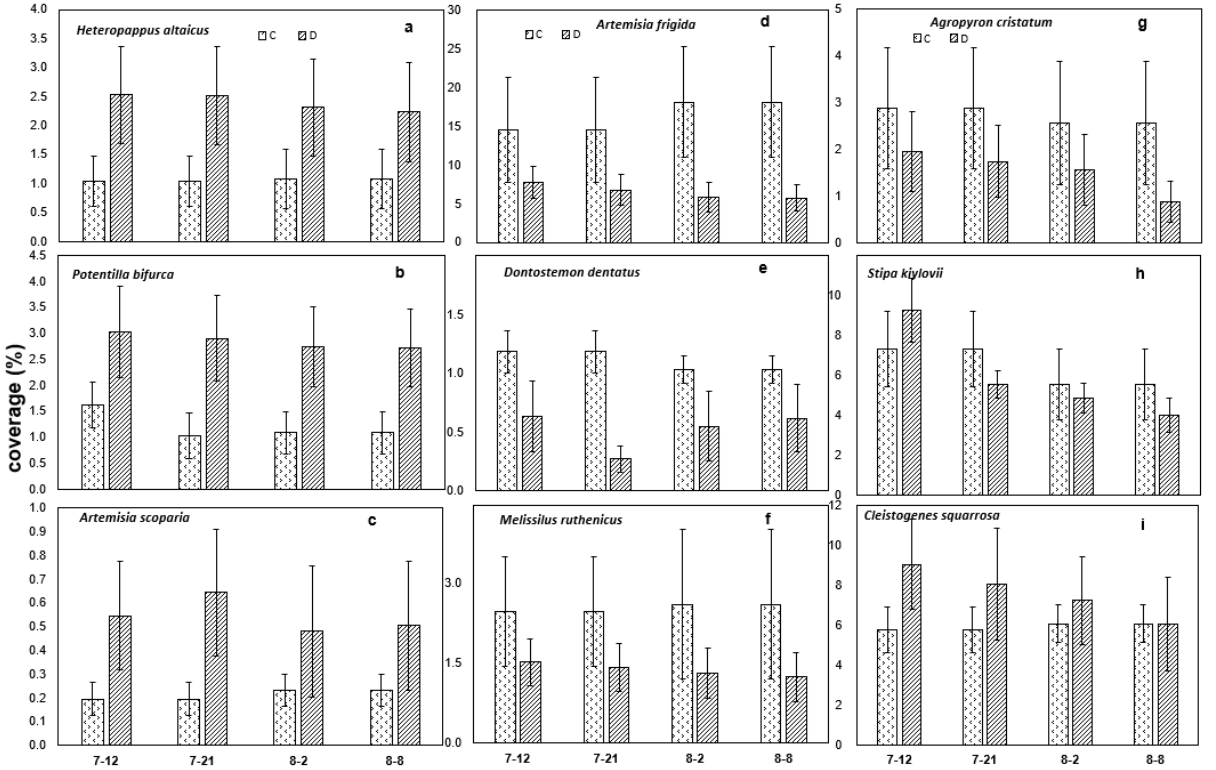
Figure 2. Effects of drought on coverage of Heteropappus altaicus ( a ), Potentilla bifurca ( b ), Artemisia scoparia ( c ), Artemisia frigida ( d ), Dontostemon dentatus ( e ), Melissilus ruthenicus ( f ), Agropyron cristatum ( g ), Stipa kiylovii ( h ), and Cleistogenes squarrosa ( i ). C: ambient precipitation; D: precipitation treatment; n = 6.